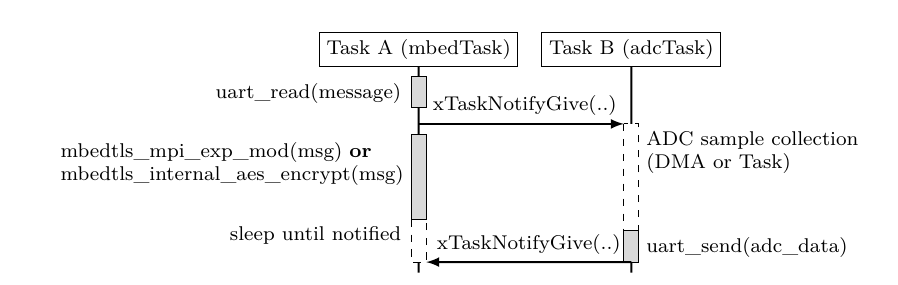
Figure 3: Description of one loop iteration of the two FreeRTOS tasks.